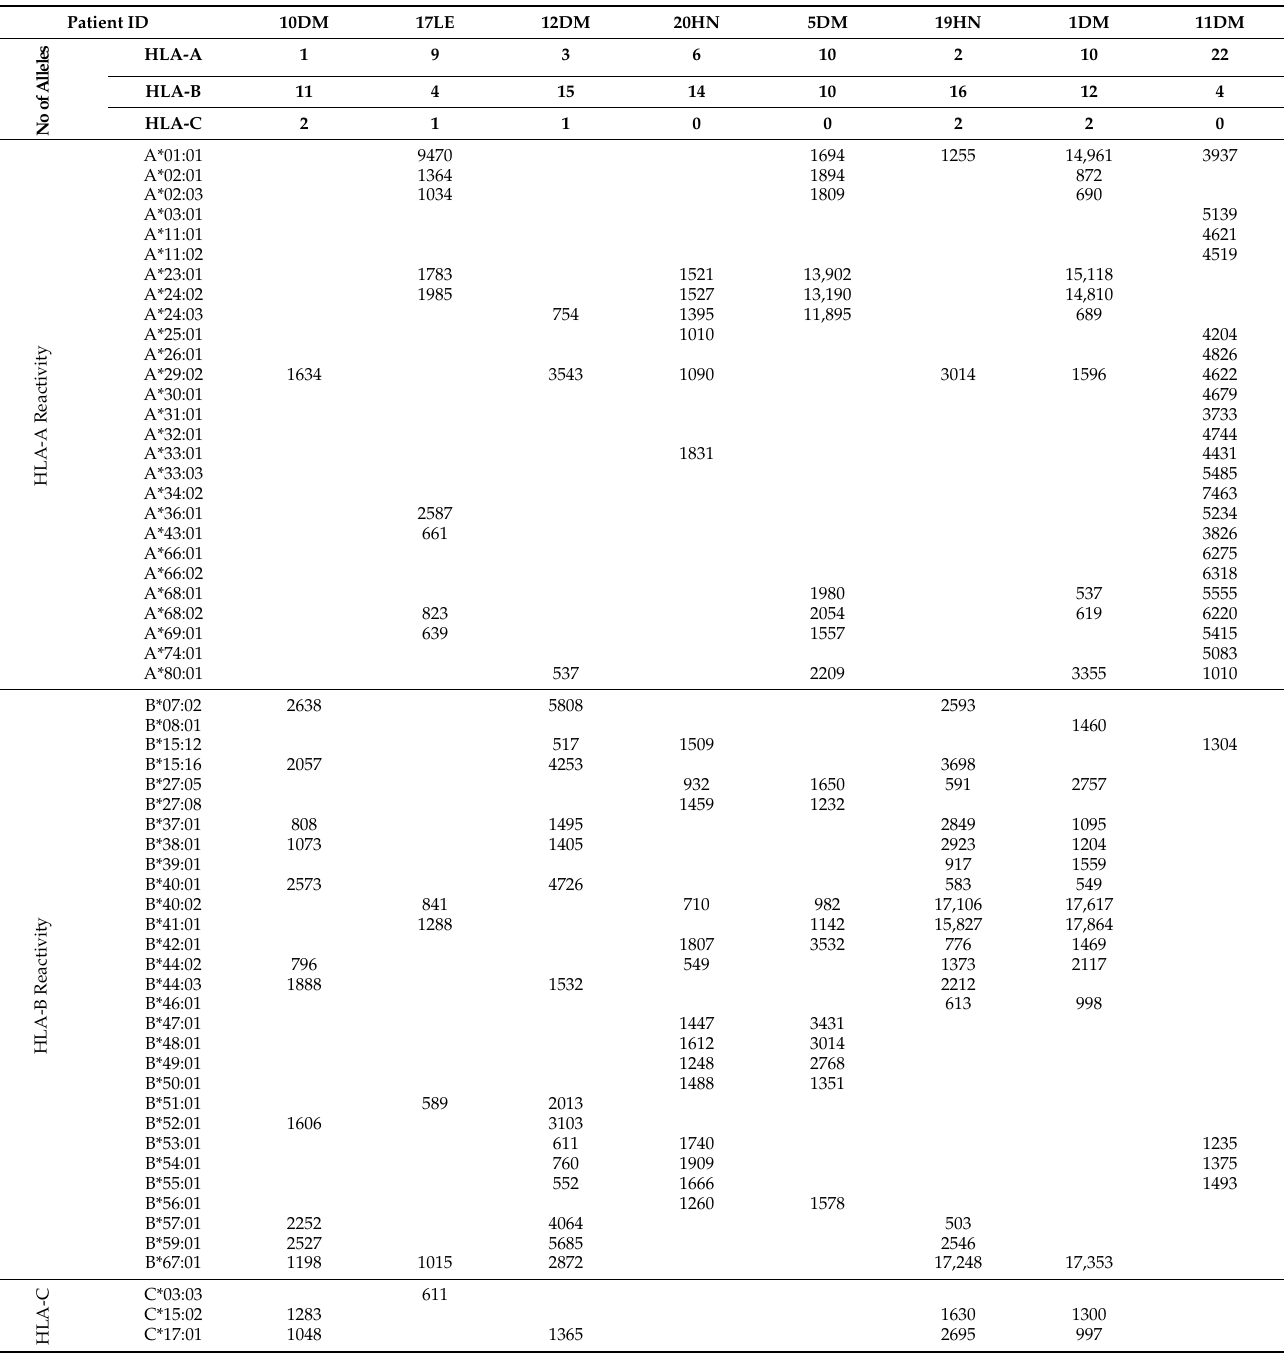
Table 13. Profiles of HLA-Ia reactivity of sera of HLA-sensitized ESKD patients waiting for